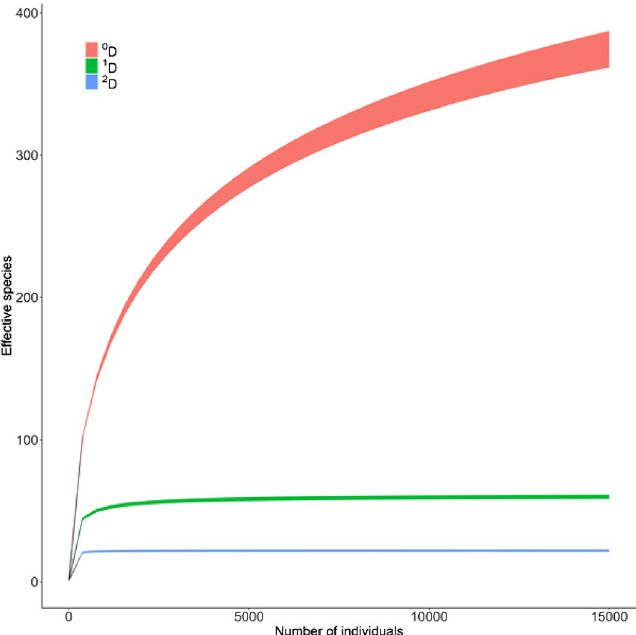
Figure 1. Accumulation curve of effective species for Hill numbers. The curve is based on the Hill numbers of order 0 D (total effective number of species), 1 D (effective number of common species) and 2 D (effective number of dominant species). Colored areas represent 95% confidence